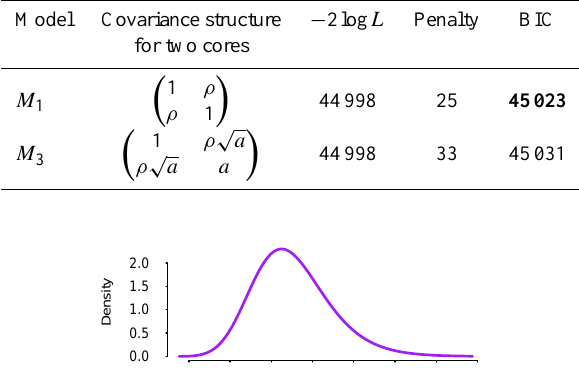
Table B1. Values of the Bayesian information criterion (BIC) ob- tained from different model settings. The bold value highlights the model with the best fit.